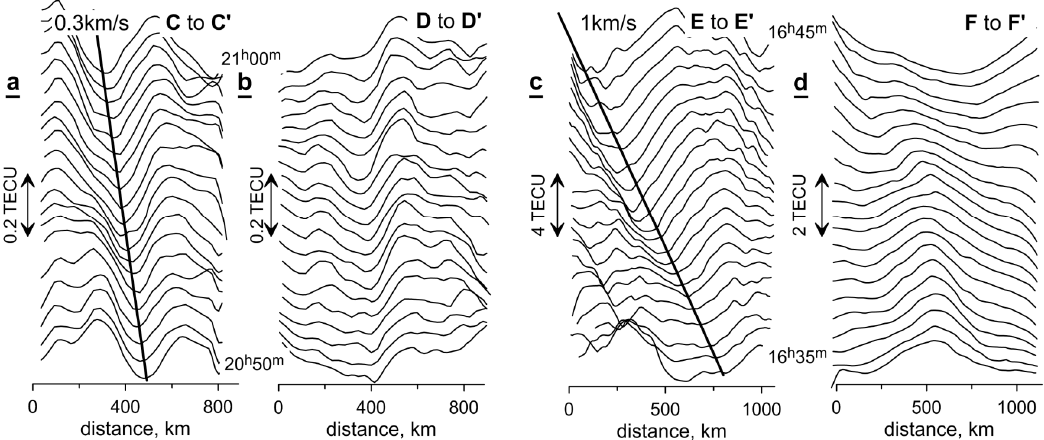
Figure 12. Profiles of TEC variations, in zones with ( a , c ) as well without ( b , d ) active travelling disturbances, along the lines C-C’ and D-D’ in Figure 8 left on 17 March 2013 ( a , b ) and along the lines E-E’ and F-F’ in Figure 8 right on 17 March 2015 ( c , d ), in the form of a “waterfall”. The bold lines show the trajectory of the disturbances.